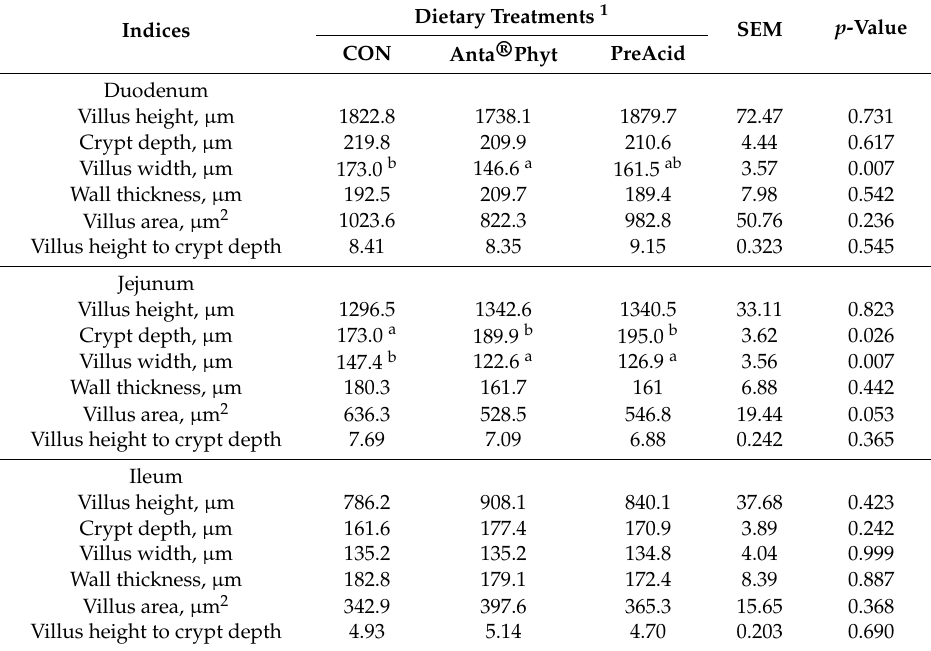
Table 4. E ff ect of dietary treatments on morphological indices of the duodenal, jejunal, and ileal mucosa in 42-d-old